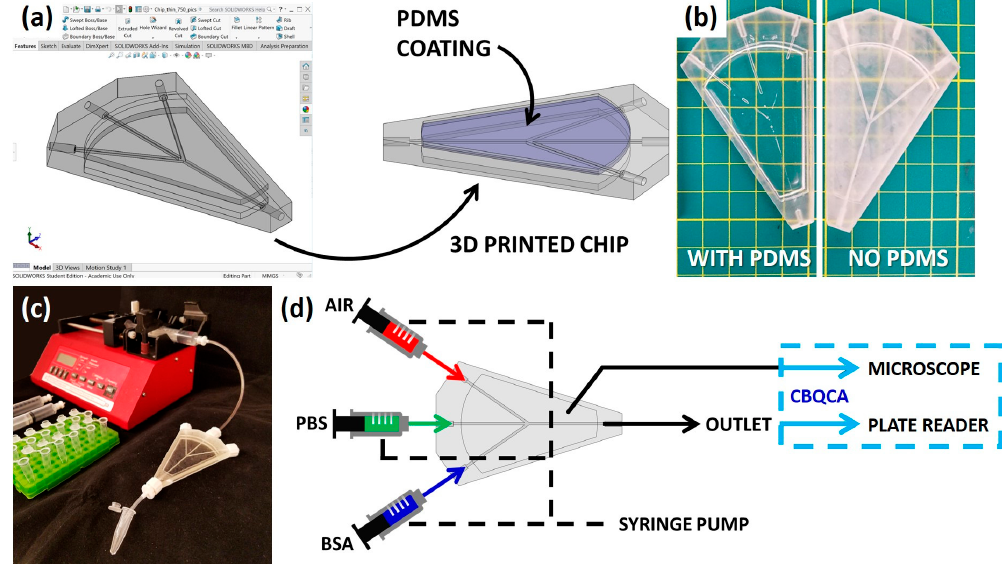
Figure 2. Overview of fabrication and experimental methods: ( a ) Microfluidic chip is first designed in SolidWorks, and then 3D-printed using a Formlabs Form 2 printer. Post-printing, a thin layer of PDMS is poured and cured on both faces of the chip; ( b ) Addition of the PDMS coating on the outside of the chip improves visibility. See a comparison of the chip with PDMS (on the left) to the chip without PDMS (on the right); ( c ) Image of experimental setup, showing the 3D-printed chip connected to a syringe pump. The sample from the outlet of the chip was collected in microcentrifuge tubes for fluorescence detection analysis; ( d ) Schematic representation of the experimental design and implementation of the 3D-printed microfluidic chip. The concentrated BSA solution, and phosphate buffered solution (PBS) as a cleaning solution, and air each have designated inlets which all converge to a single outlet. The sample from the outlet, collected at set intervals, and the chip itself are then analyzed for the protein concentration by the CBQCA quantitation method using a plate reader and microscope, respectively.